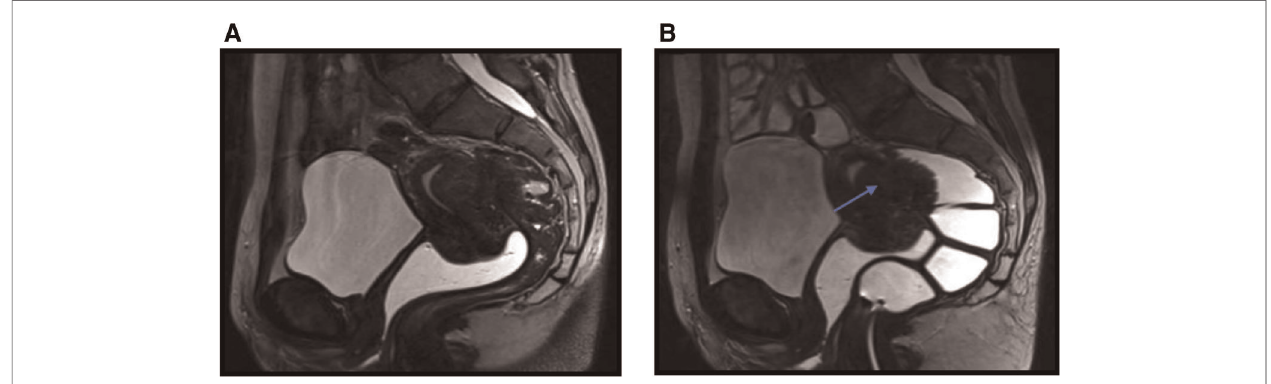
FIGURE 1 | SAG TSE T2w, Intestinal involvement: ( A ) precolic distension, ( B ) postcolic distension with PEG; demonstrates a large endometrioma (thin arrow) adjacent to a recto-sigmoidal junction.